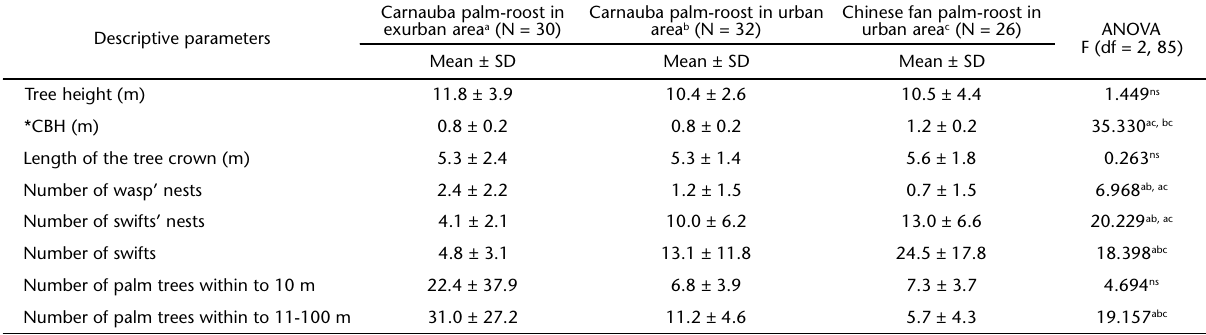
Table I. Descriptive parameters of the palm trees used by the Neotropical palm swifts for roosting in the Brazilian semiarid region. Significant p-values: abc p (cid:4) 0.05; ns = non-significant; *CBH = trunk circumference at breast height. Descriptive